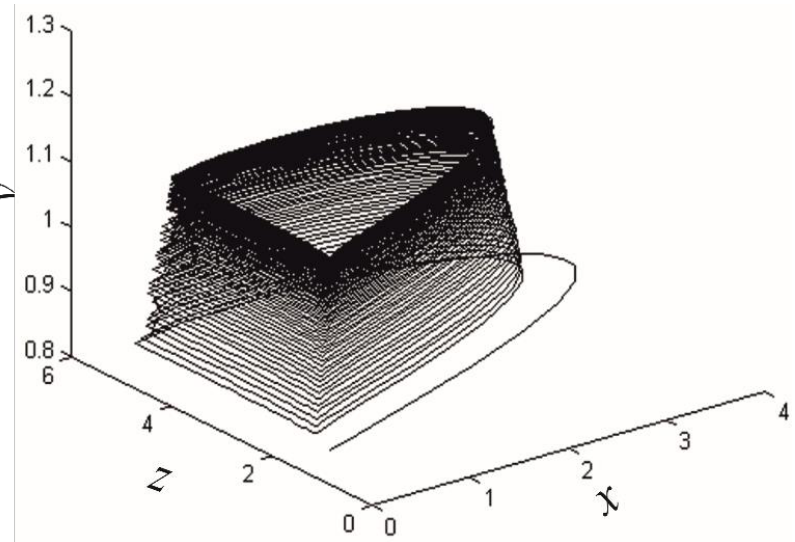
Figure 12. The three-dimensional attractor ( x , z , v ) for high flux in dynamic Györgyi–Field system ( α = 3000/9; β = 6/23; C = 0.001; A = 0.14 mol; M = 0.3 mol; H = 0.26 mol and k f = 6.18 × 10 −4 ).